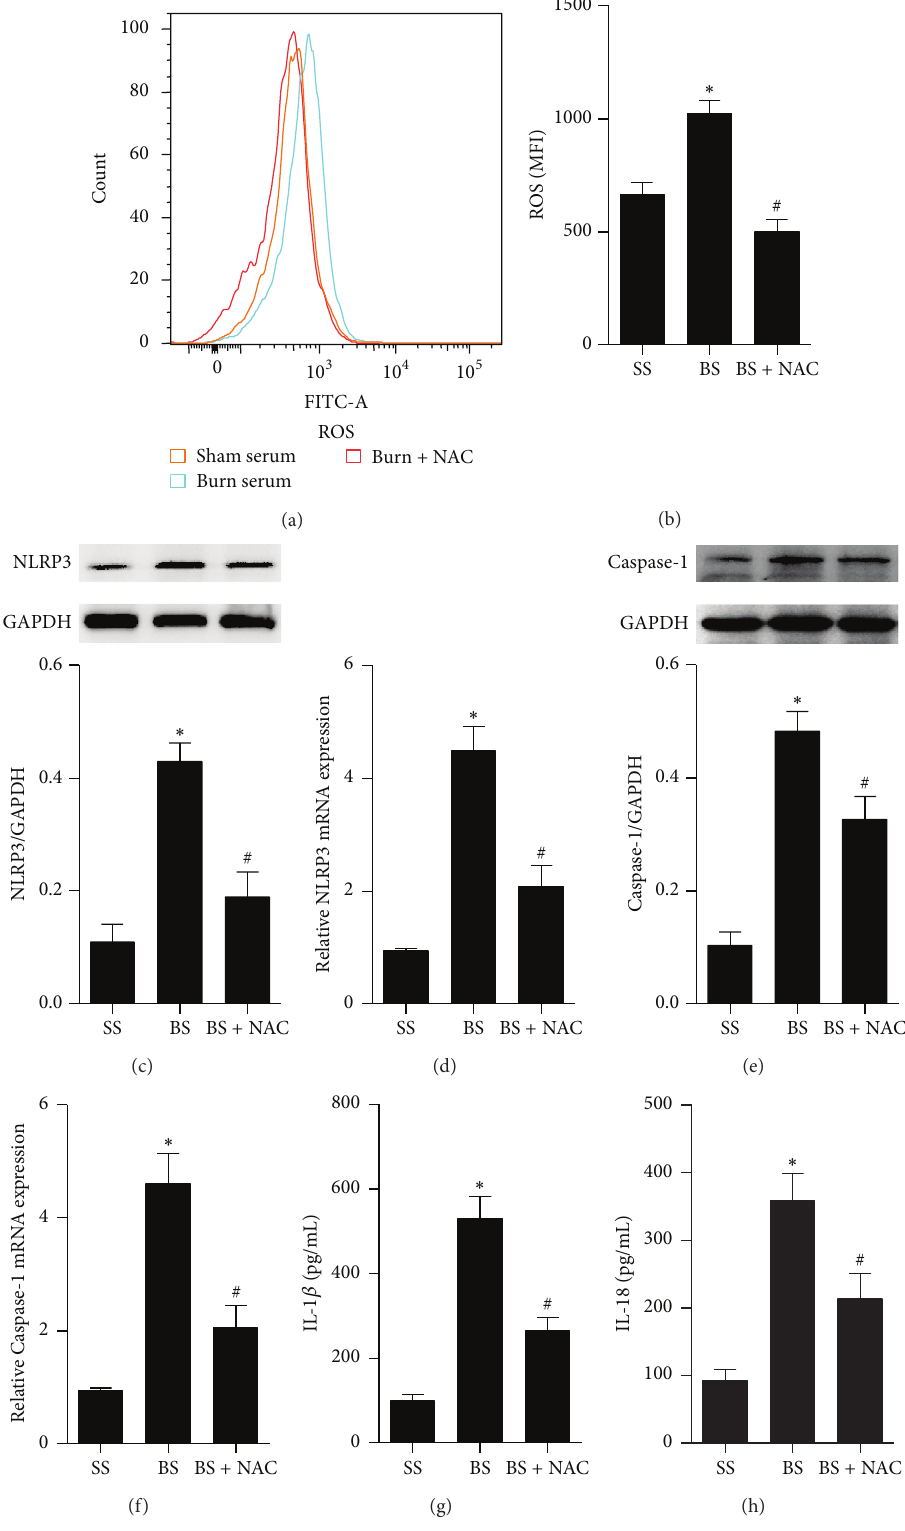
Figure 6: ROS scavenger inhibited the activation of NLRP3 inflammasome in AMs exposed to burn serum. AMs were challenged with burn serum with NAC, a ROS scavenger, for 24 h or 48h. ROS were examined by way of FACS (a) and were quantified by way of mean fluorescence intensity (b). The activation of NLRP3 ((c) and (d)) and Caspase-1 ((e) and (f)) was measured by immunoblots or real-time PCR. The release of IL-1 𝛽 (g) and IL-18 (h) in the supernatant was tested by ELISA. Results represent mean ± SEM of six independent experiments. ∗ 𝑃 < 0.05 compared to the value at SS group. # 𝑃 < 0.05 compared to the value at BS group. SS, sham serum; BS, burn serum; AM, alveolar